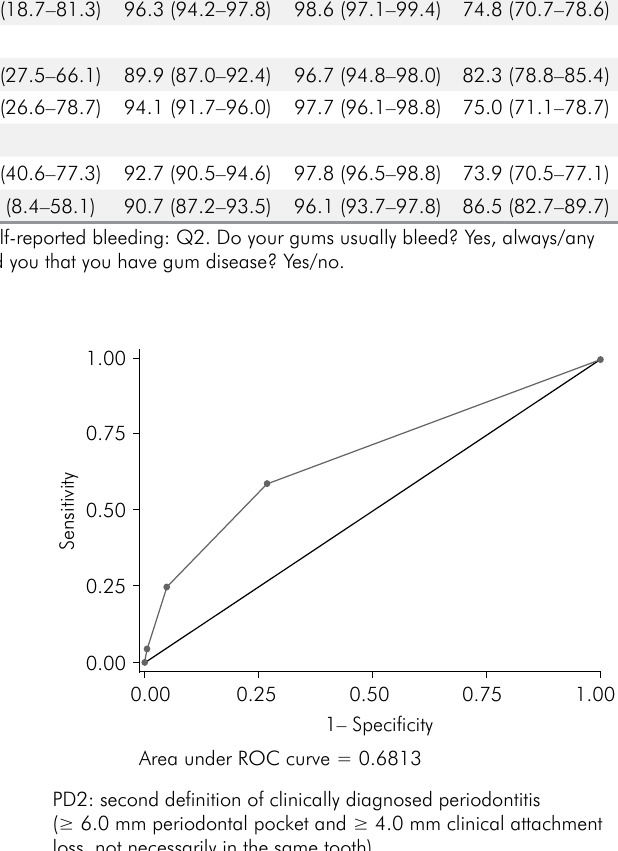
Figure 1. Receiver operating characteristic (ROC) curve for the three unweighted self-reported items on periodontal conditions, considering PD1 as the gold